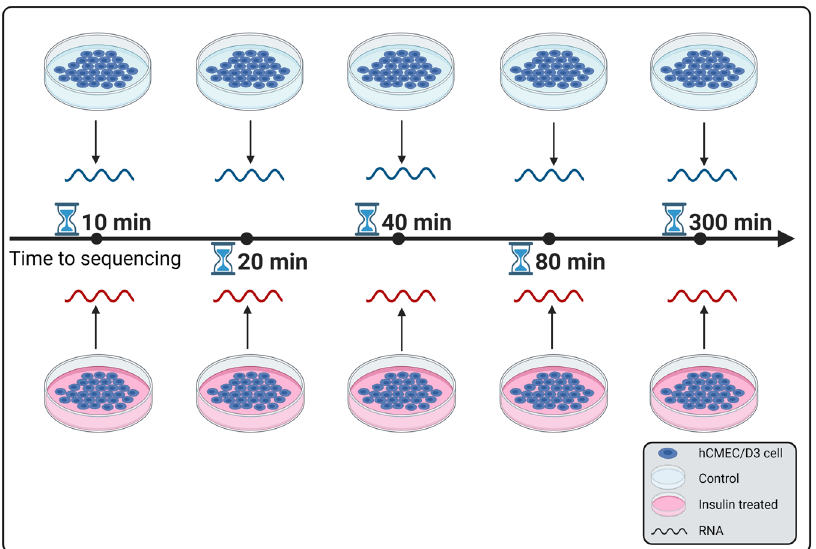
Fig. 5 RNA-Sequencing experimental design. Human cerebral microvascular endothelial cell (hCMEC/D3) monolayers were treated with and without insulin for 10, 20, 40, 80 and 300 minutes. Paired-end RNA libraries from control and insulin-treated cell monolayers were